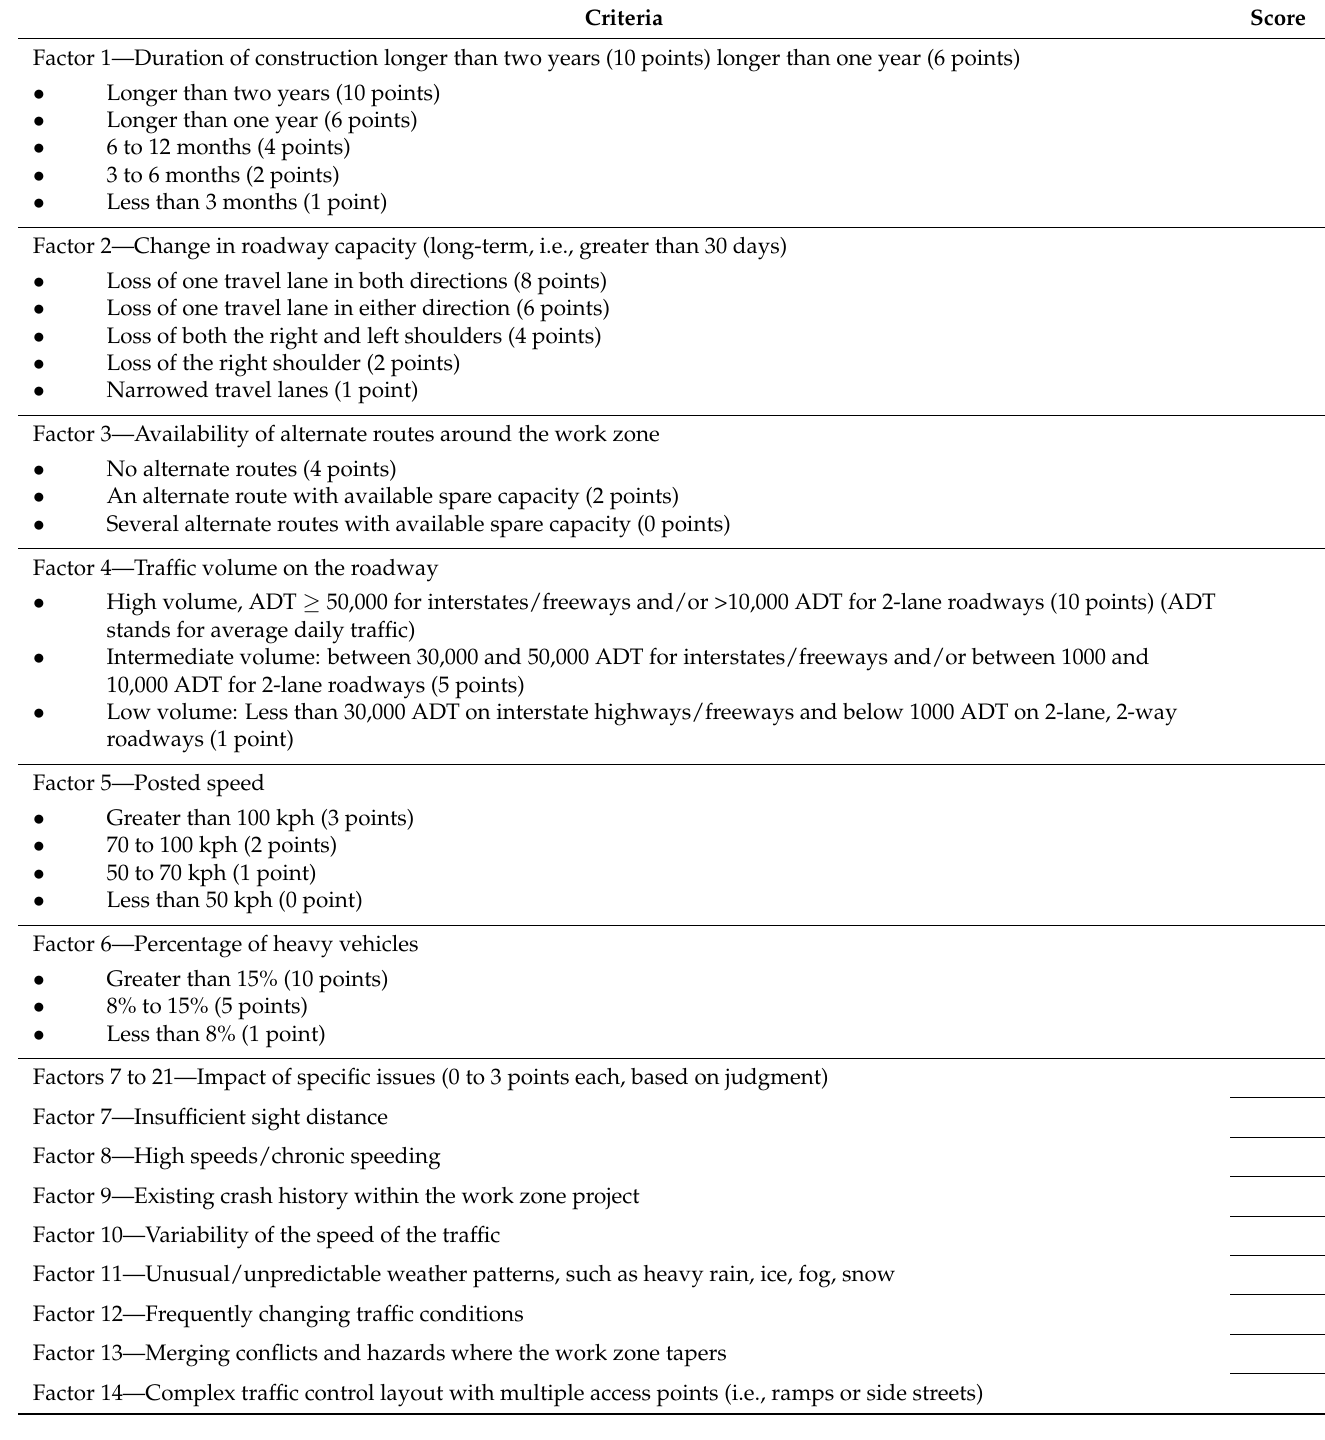
Table 2. Work zone ITS feasibility assessment tool including scoring